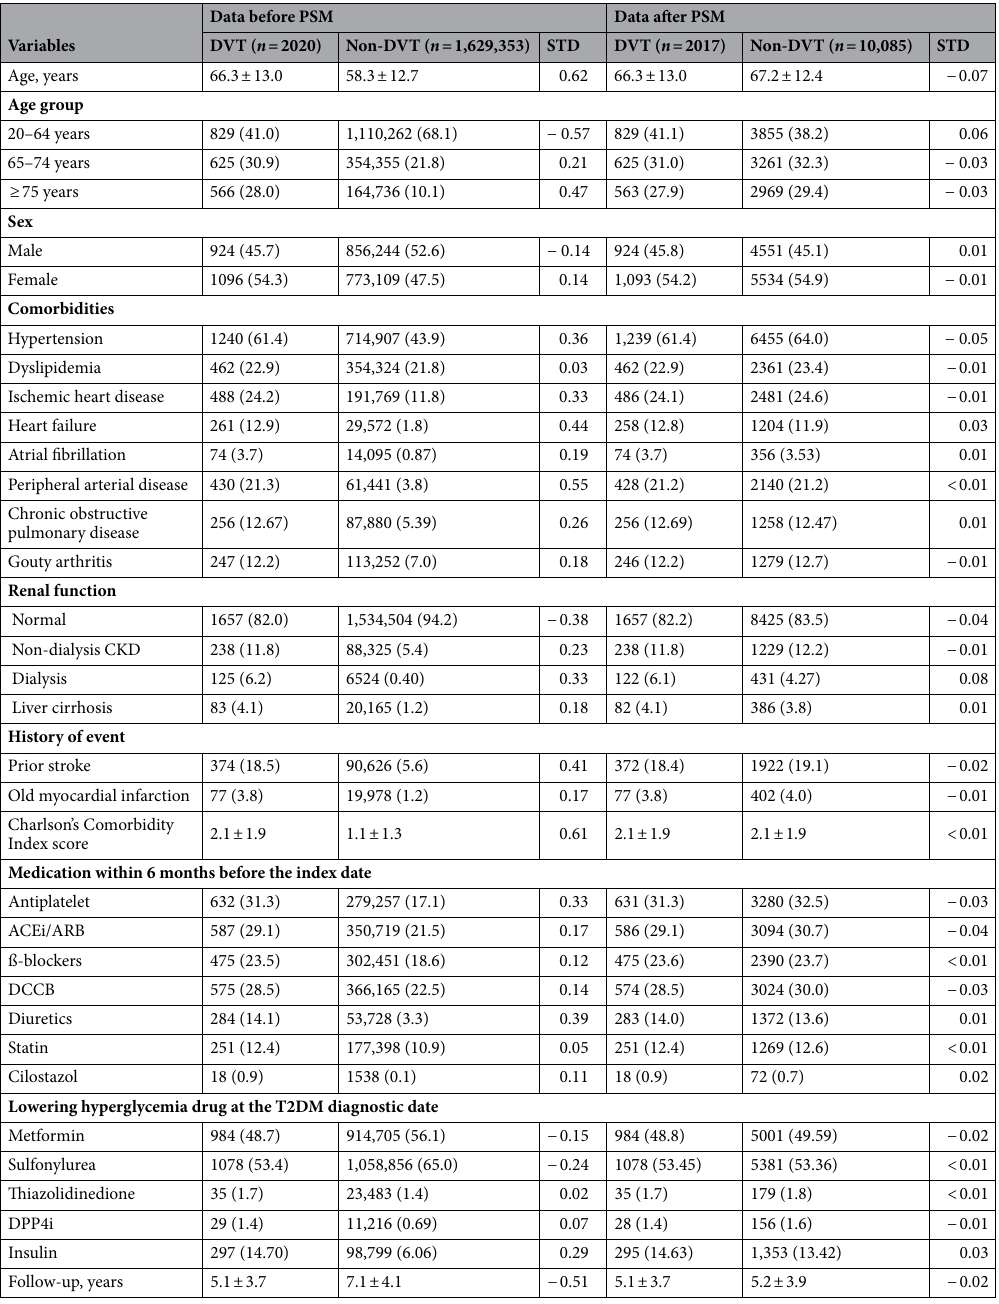
Table 1. Baseline characteristics of the T2DM patients with or without coexisting DVT before and after propensity score matching. T2DM type II diabetes mellitus, PSM propensity score matching, DVT deep vein thrombosis, STD , standardized difference, CKD chronic kidney disease, ACEi angiotensin converting enzyme inhibitor; ARB angiotensin receptor blocker, DCCB dihydropyridine calcium channel blockers, DPP4i Dipeptidyl peptidase-4